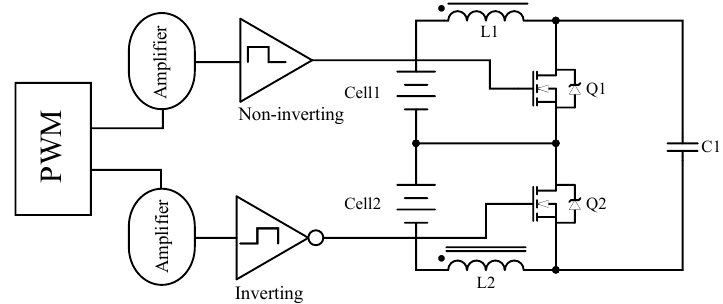
Figure 15. The control flowchart of the proposed ´cuk converter balancing circuit.